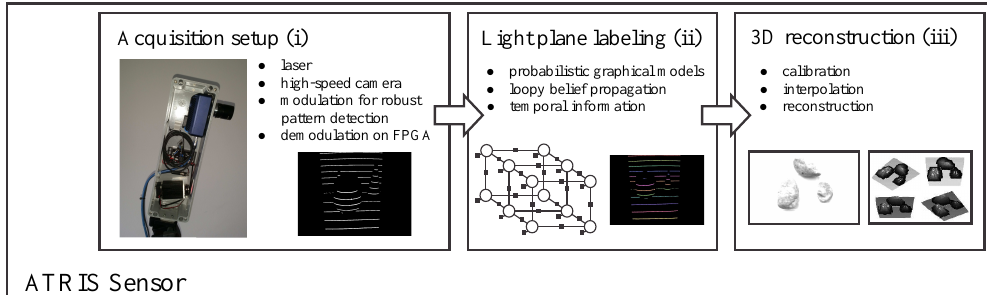
Figure 1. Schematic representation of our active triangulation system (ATRIS) sensor. The sensor comprises three key components: (i) an image acquisition procedure, which captures an image of the projected light pattern; (ii) a light plane labeling technique, which establishes the correspondence between all parts of the projected and detected patterns; and (iii) a 3D reconstruction procedure, which constructs a depth image from the detected light